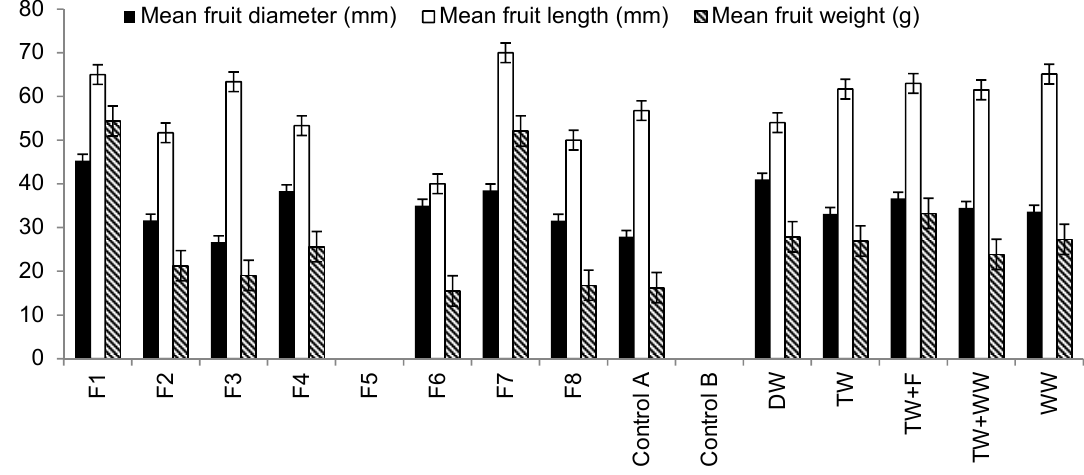
Figure 5. Differences in mean fruit diameter, mean fruit length and mean fruit weight linked to harvested plants (20 January to 25 September 2014) irrigated with different water types and grown in organic media. Notes: No fruit harvest has been noted for plants associated with Filter 5 and Control B.